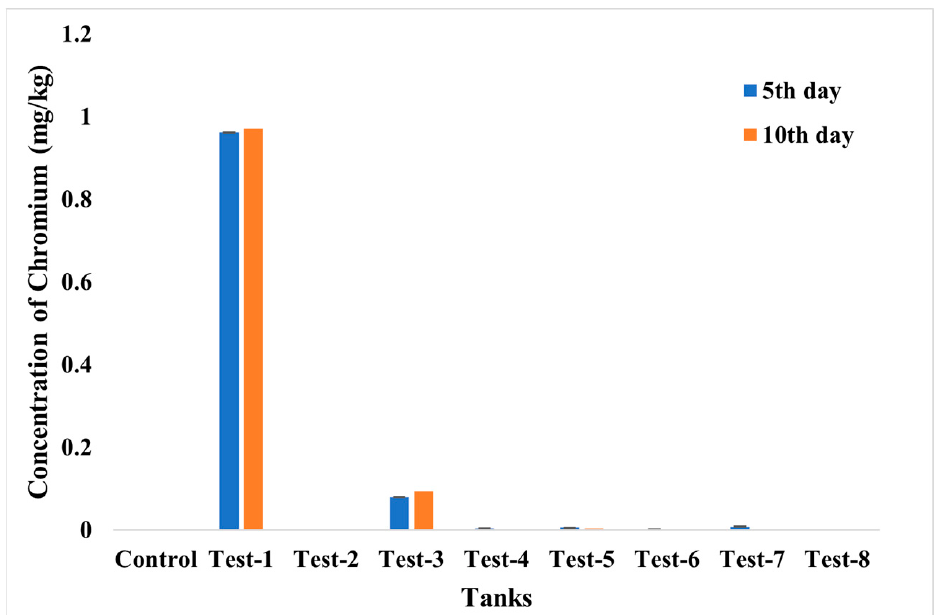
Figure 15. ICP—MS analysis for chromium accumulation analysis in control; Test 1 —Chromium